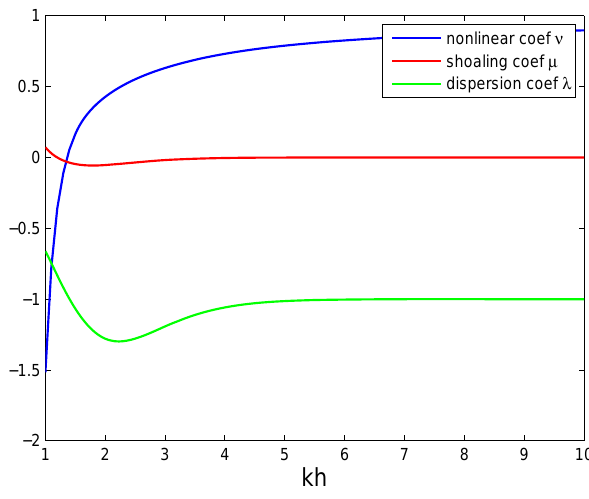
Fig. 1. Three coefficients with respect to dimensionless depth kh